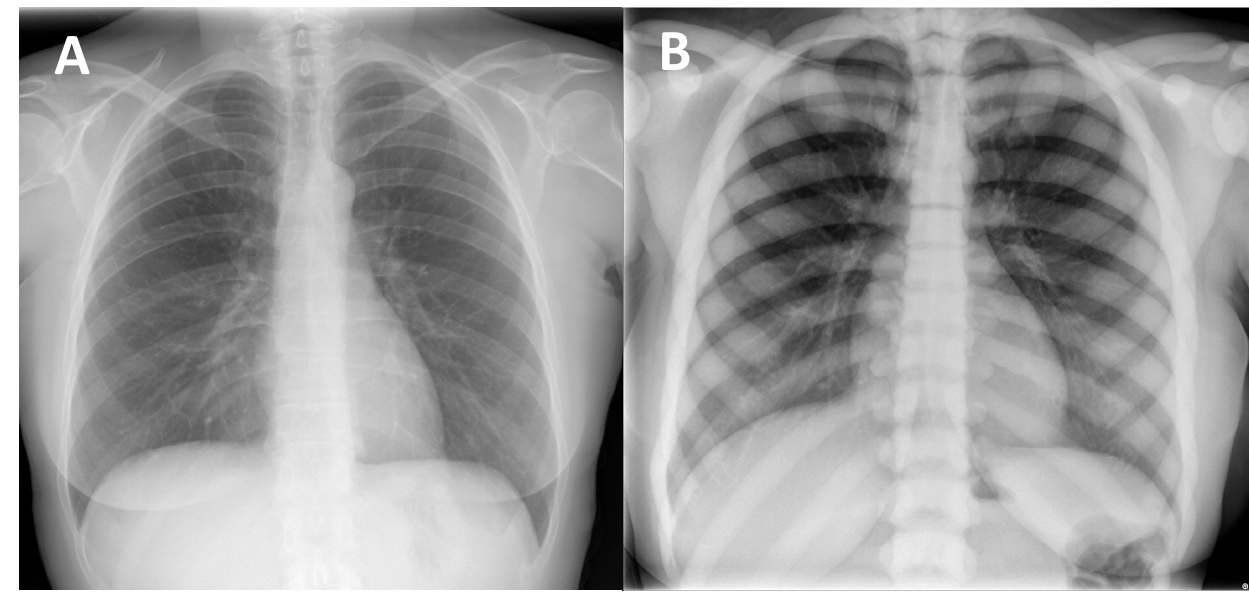
Figure 1. ( A ) conventional radiography of the chest of a young healthy female (shown as comparison). ( B ) conventional radiography of the chest in a 29-year-old female diagnosed with osteopetrosis (clinical and radiological diagnosis in absence of a pathogenic variant in osteopetrosis-related genes). All the skeletal segments included are affected by diffuse and markedly increased bone density (spine, ribs, clavicle, scapulae, humerus): ‘Marble bone’ appearance. (2) Defects, enlargement/expansion, and other alterations at long bone metaphysis, which appear widened sometimes with a funnel-like shape (the so-called Erlenmeyer flask deformity) (Figure 2).